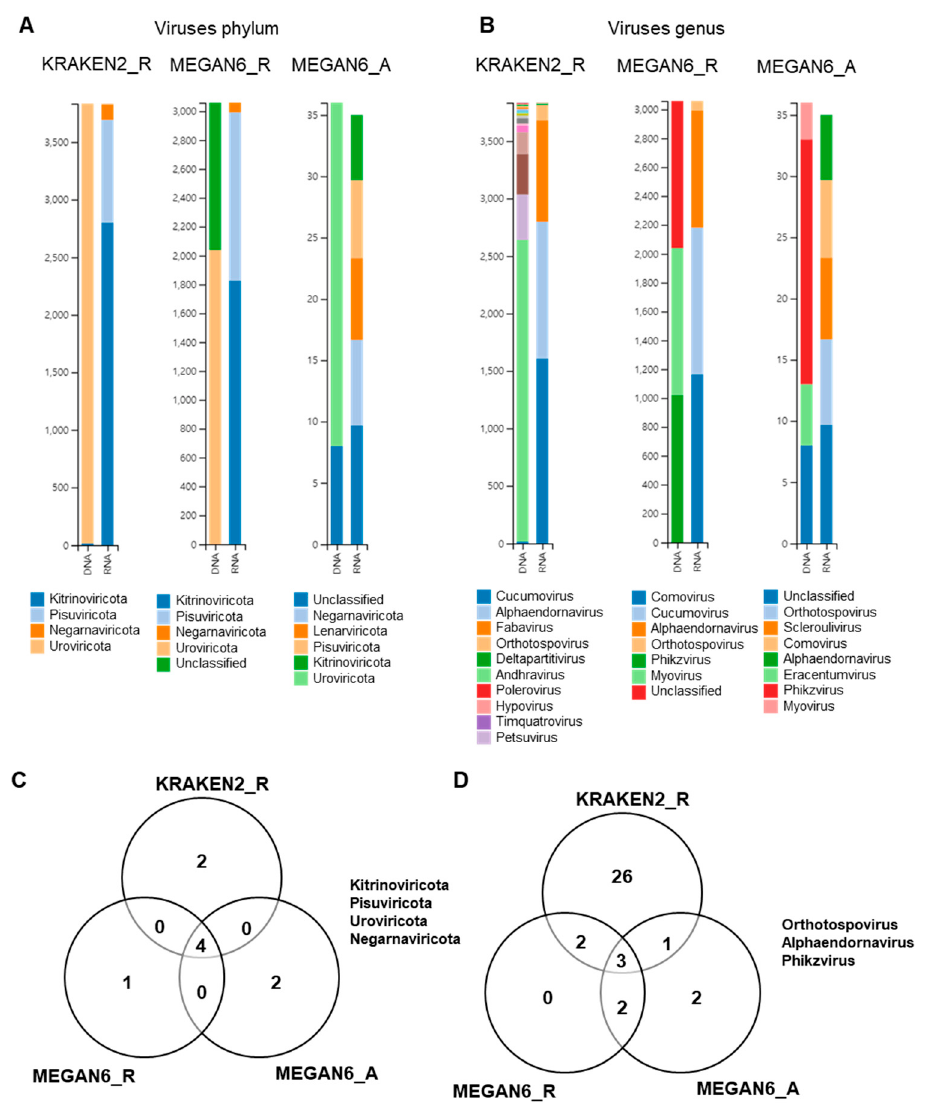
Figure 10. Comparison of identified viruses at phylum and genus levels by three different analytical methods (i.e., KRAKEN2_R, MEGAN6_R, and MEGAN6_A). Proportion of identified viral phyla ( A ) and genera ( B ). Commonly identified phyla ( C ) and genera ( D ) among three different analytical methods.